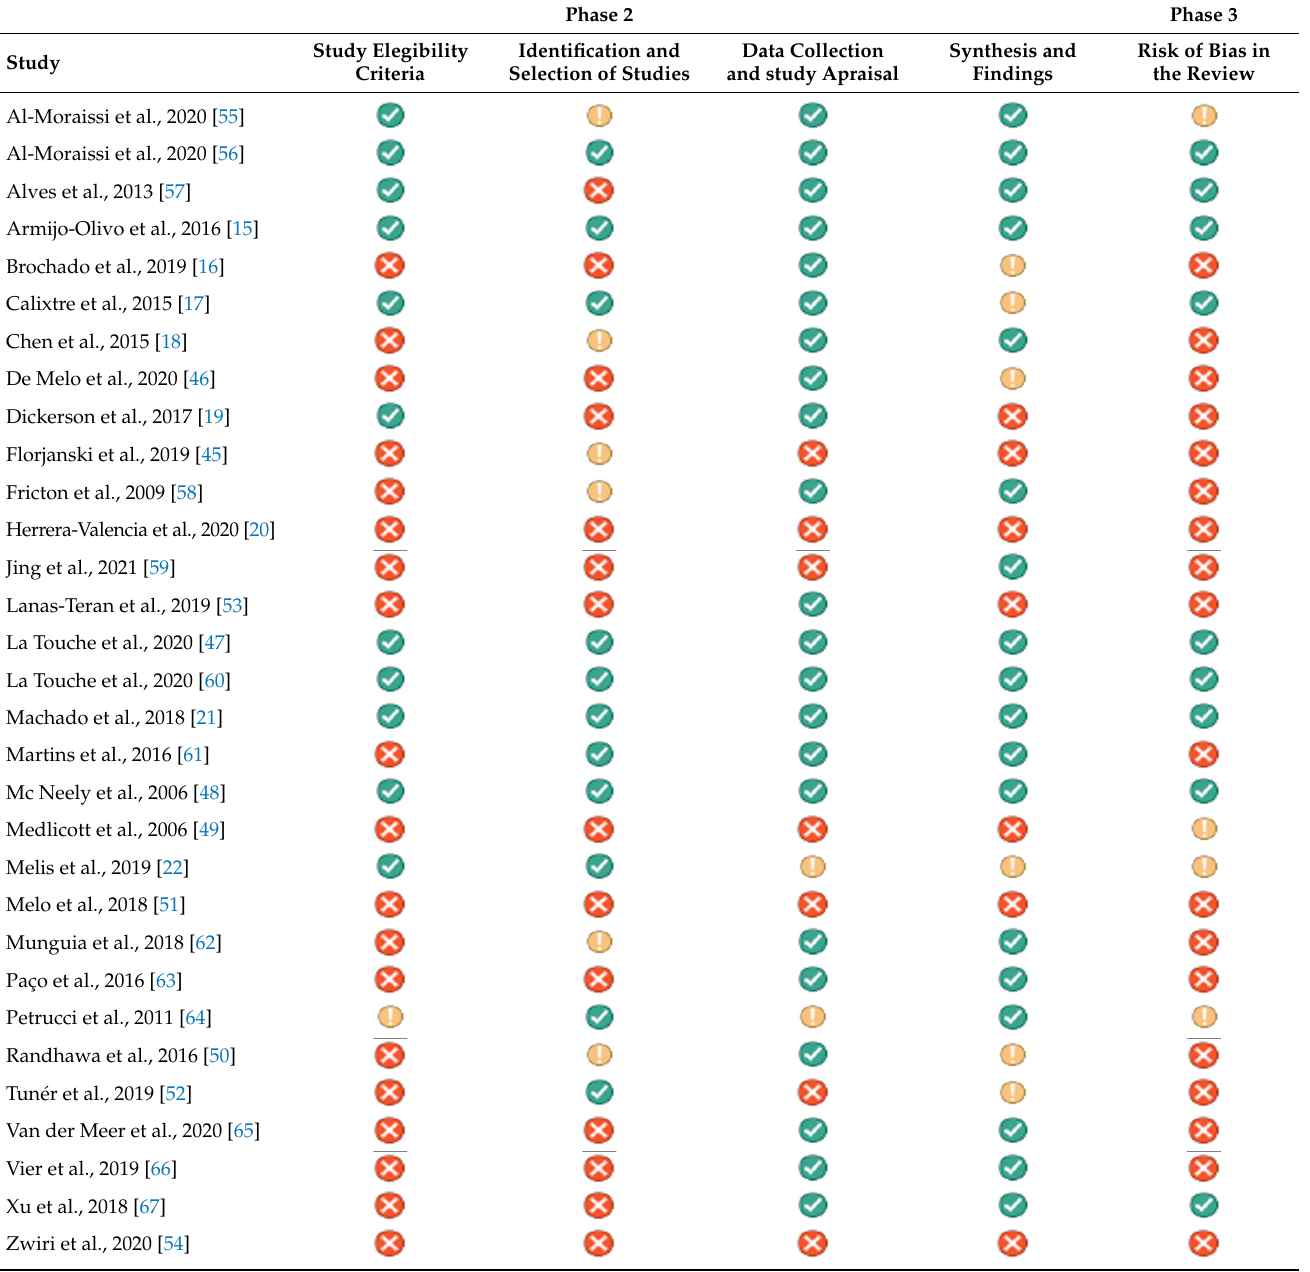
Table 4. Risk of bias assessment in systematic reviews through the ROBIS scale.